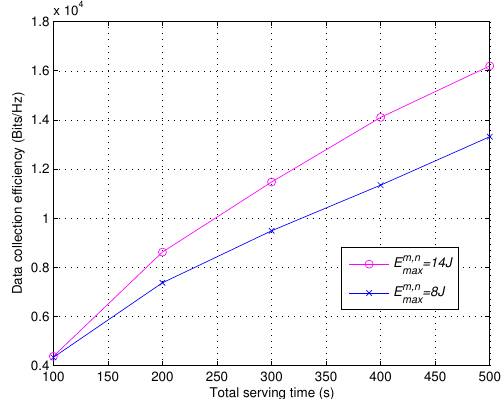
Figure 7. Comparison of data collection efficiency versus total energy constraint of each device for the proposed iterative algorithm and the traditional scheme, both with the aid of the proposed trajectory planning scheme and beam selection scheme.